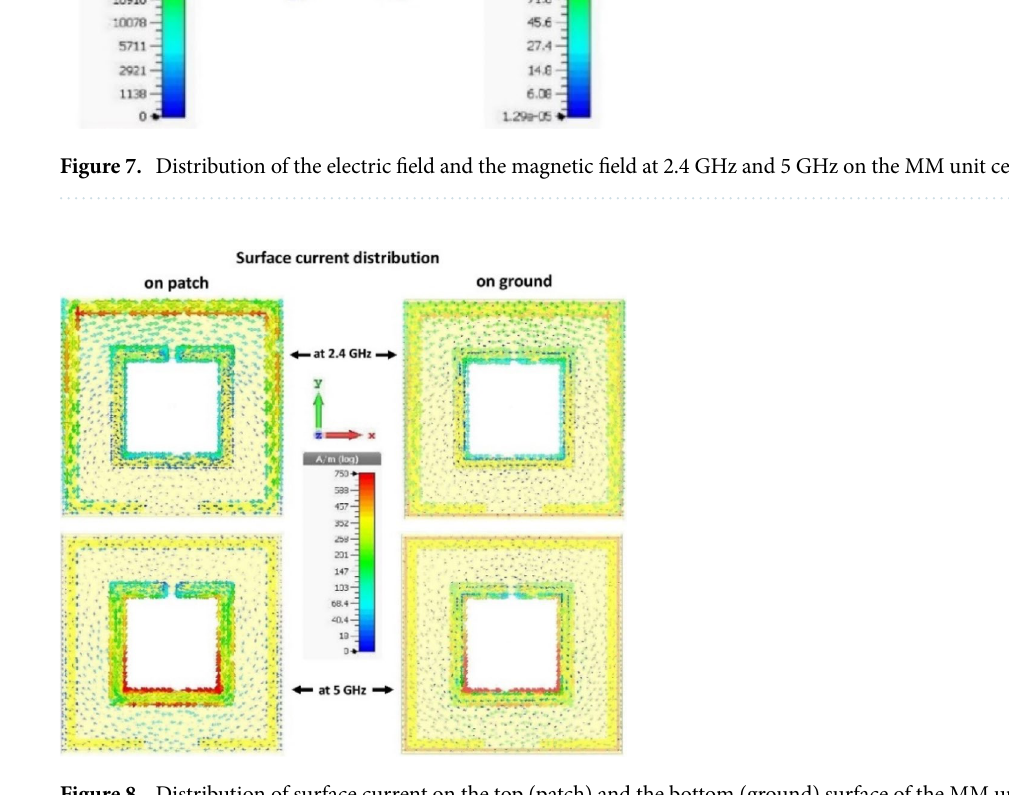
Figure 8. Distribution of surface current on the top (patch) and the bottom (ground) surface of the MM unit cell at 2.4 GHz and 5